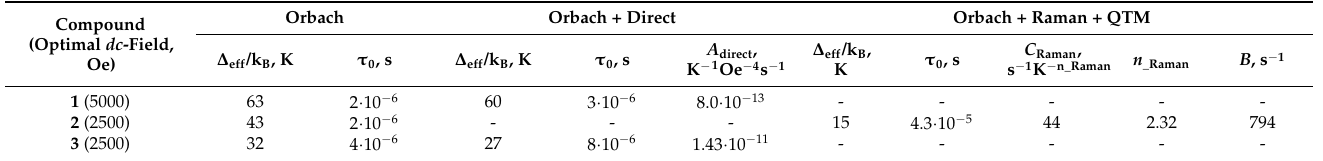
Table 4. The best-fit parameters of magnetization relaxation for 1 – 3